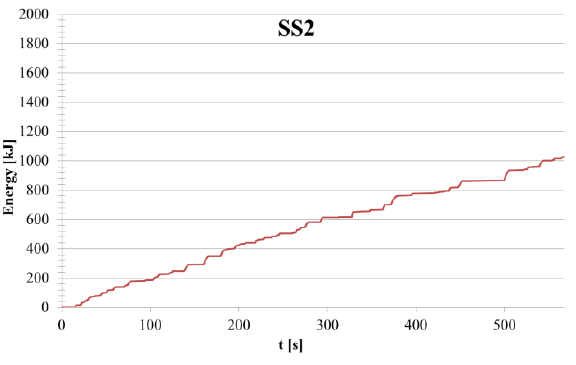
Fig. 5. Braking energy and vehicle speed during SS2